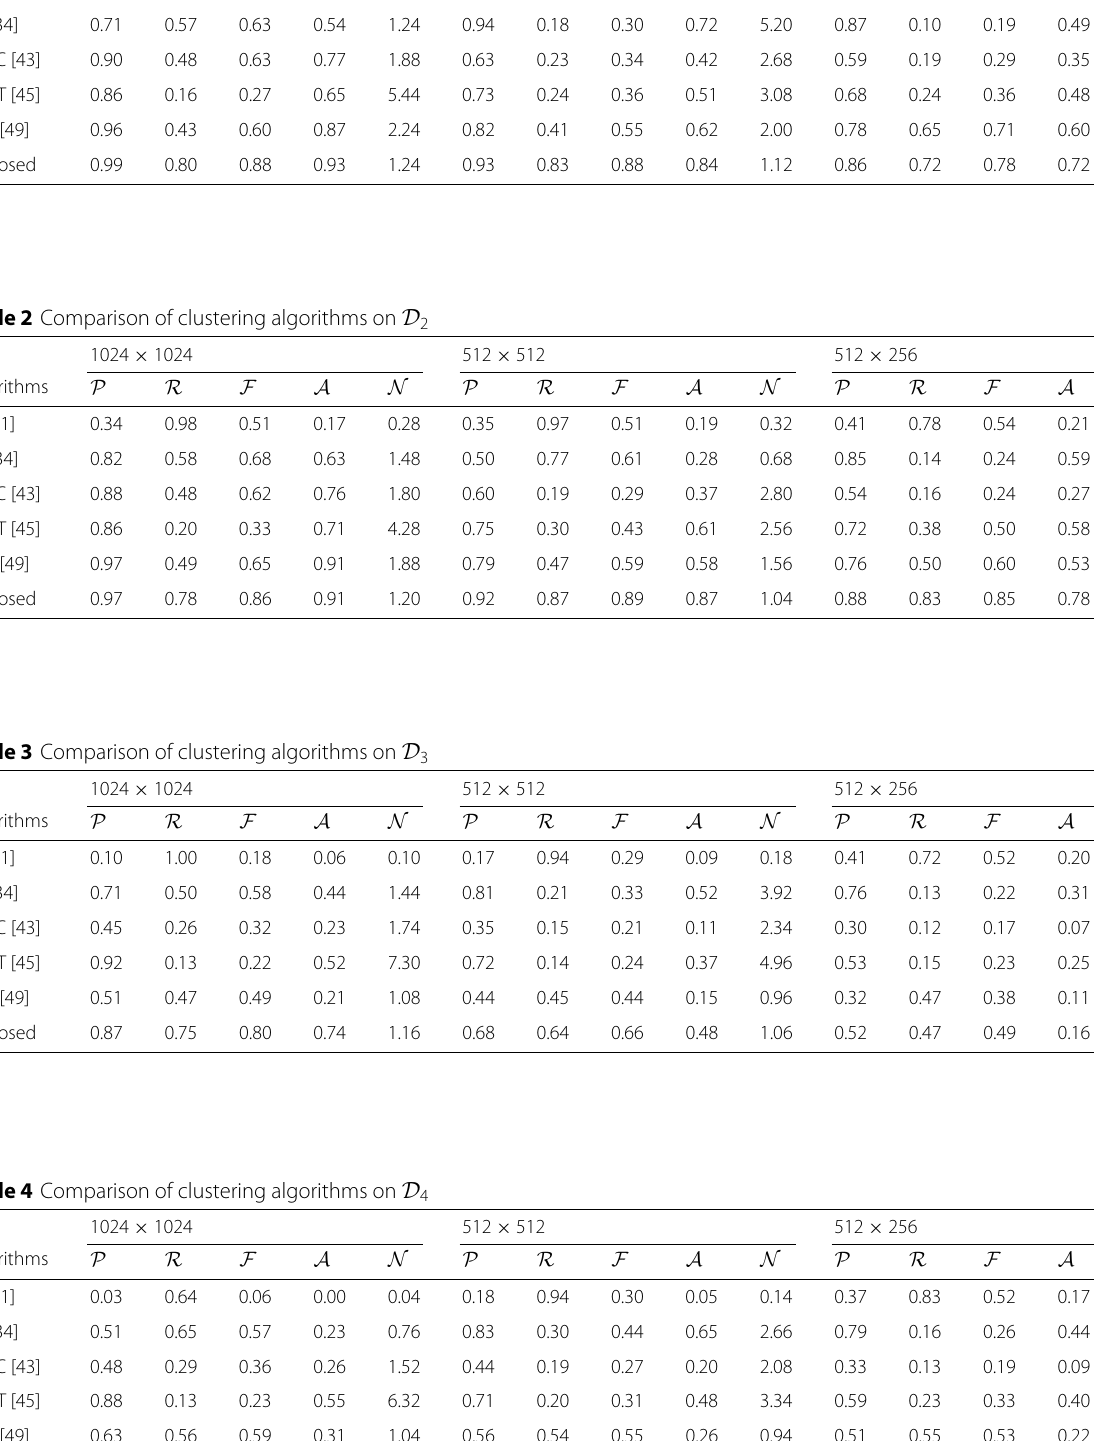
Table 1 Comparison of clustering algorithms on D 1 Algorithms